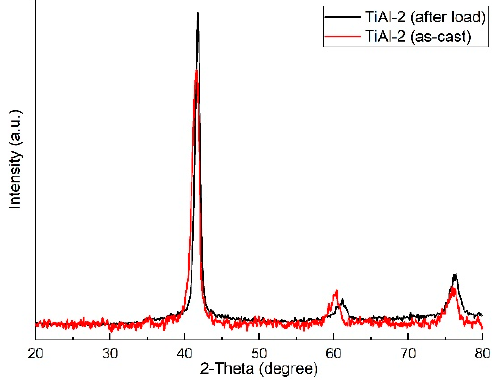
Figure 9. XRD pattern of alloy Al-2 in as-cast and after loading.